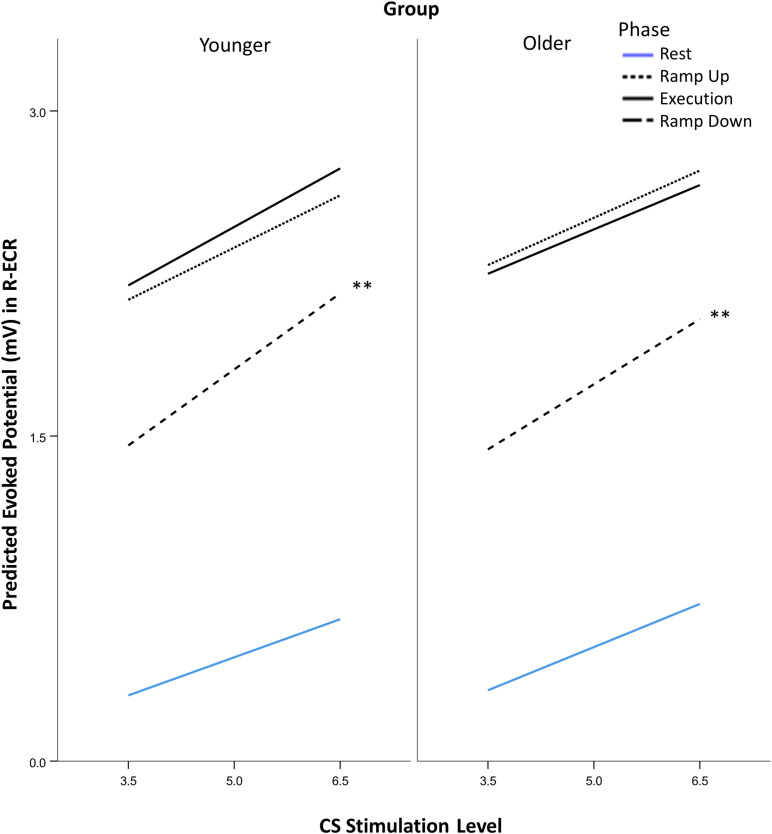
Comparison of suprathreshold corticospinal recruitment in the active R-ECR across phases of contraction for younger and older participants across conditioning stimulation (CS). See section “Statistical Analysis” for explanation of stimulation levels graphed on the x-axis. Asterisks indicate that Ramp Down slopes were significant different from each of the other phases from the mixed-effects liner model, planned contrast t-test **p < 0.01.